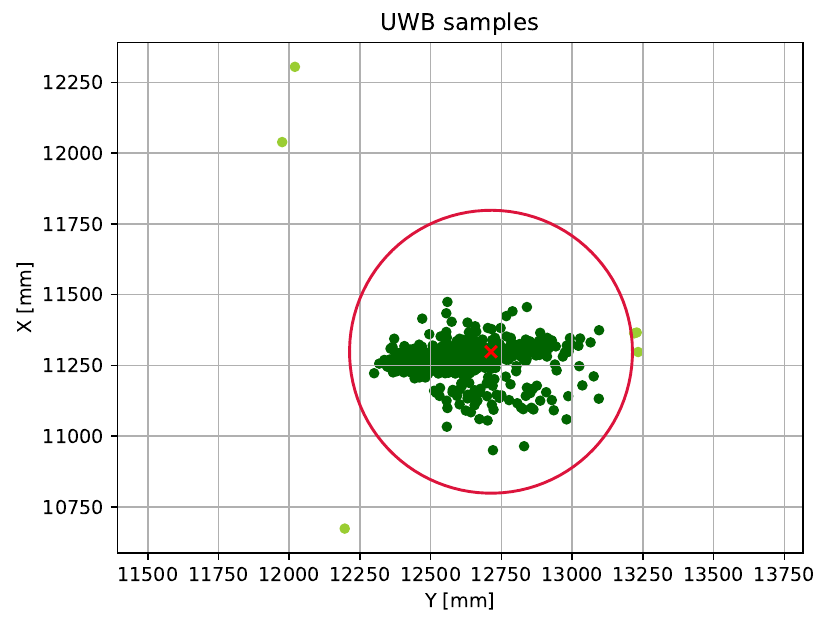
Figure 9. Position dataset created by a static